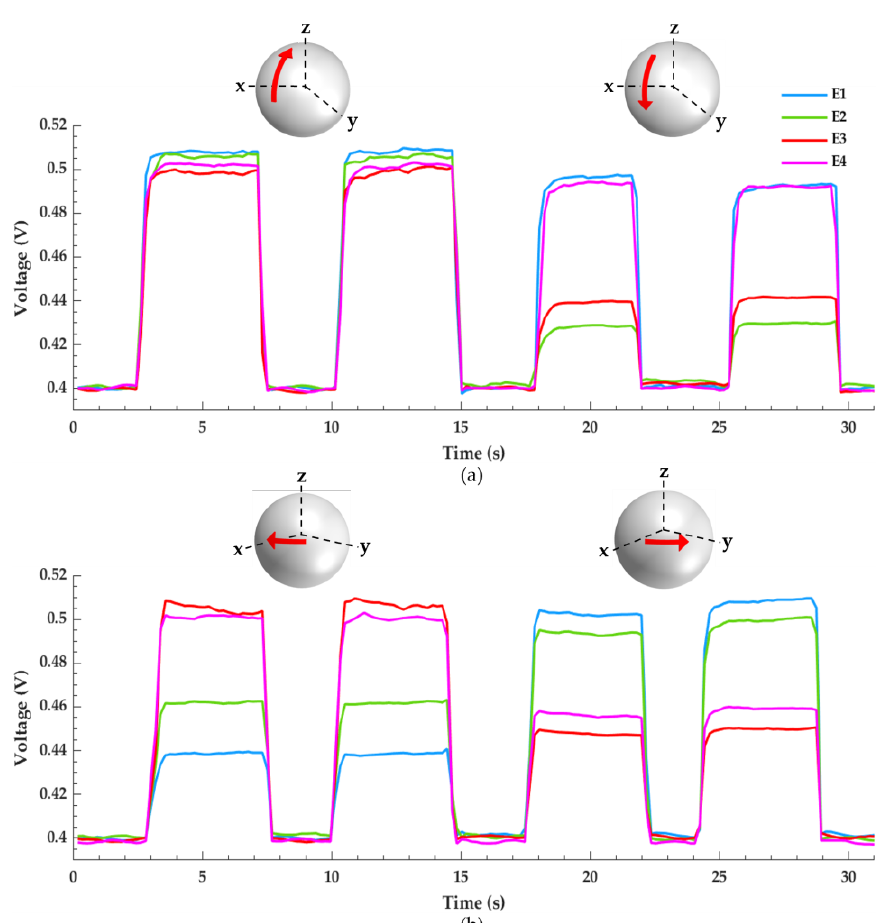
Figure 6. Pressure distribution across the four sensing electrodes as the sensor–humeris model is compressed against the glenosphere. ( a ) The first pair of waveforms show an almost uniform pressure distribution across the electrodes, indicating a fully abducted shoulder. The second pair of waveforms show that electrodes E1 and E4 experience the greatest magnitude of pressure, indicating a fully adducted shoulder. ( b ) The first pair of waveforms show that electrodes E3 and E4 experience the greatest magnitude of pressure, indicating a shoulder that is internally rotated. The second pair of waveforms show that electrodes E1 and E2 experience the greatest magnitude of pressure, indicating a shoulder that is externally rotated.